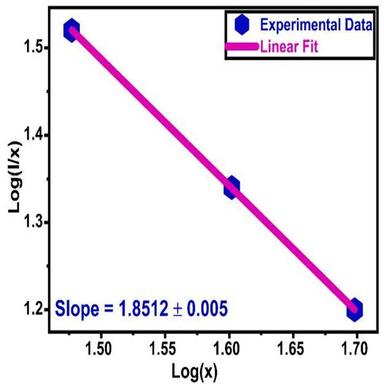
A linear variation of Log(I/x) with Log(x) in Ba2La4(1-x)Zn2O10: 4xEu3+ (x = 5.0–10.0 mol%) nanophosphor.